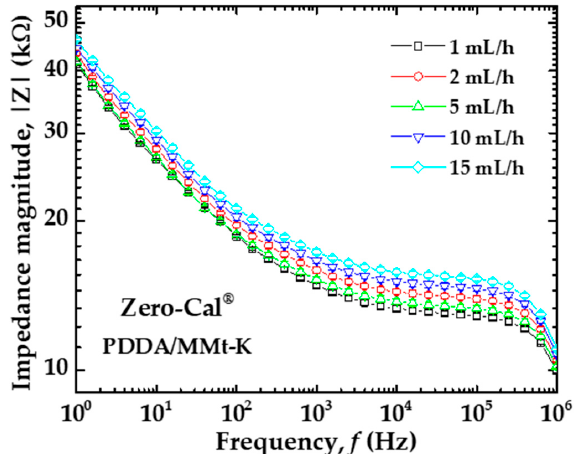
Figure 7. Impedance magnitude versus frequency spectra for the PDDA/MMt-K sensing unit under distinct flow rates of Zero-Cal ® sucralose-based sweetener in aqueous solution (10 µL/mL).